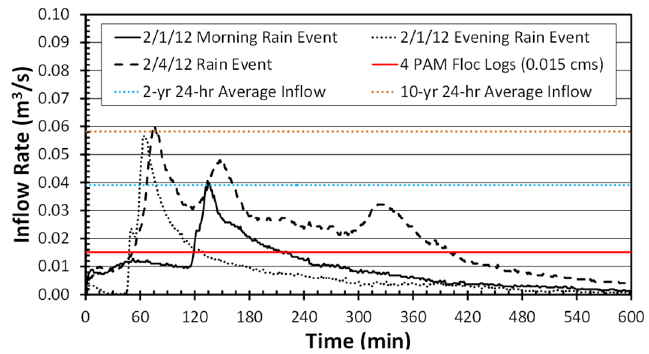
Figure 7. Observed inflow hydrographs for several rainfall events during the Phase I ( top ) and Phase II ( bottom ) data collection including effective flow rate using four floc blocks and average inflow rates for 2-year and 10-year 24-h design storms, where cms is m 3